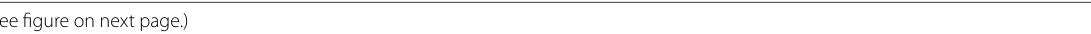
Fig. 1 Tetrandrine inhibit RANKL-induced osteoclastogenesis. A The chemical structural formula of Tetrandrine; B Tetrandrine impact on BMMs viability was detected by CCK-8 assay at 48 h and 96 h. C With different dilutions of Tetrandrine, M-CSF and RANKL for 7 days, BMMs were processed; scale bar 200 μm. D The number and area of TRAP-positive cells. E TRAP-positive BMMs after the treatment with 1 μM Tetrandrine for the = designated days in the process of osteoclastogenesis; scale bar 200 μm. F To quantify TRAP-positive cells, the number and area of osteoclasts. = G Immunofluorescence image for showing the formation of F-actin. All experiments were carried out in triplicate. The results were presented as mean SEM. * P < 0.05, ** P < 0.01, *** P < 0.005 and **** P < 0.001 as compared with the ±